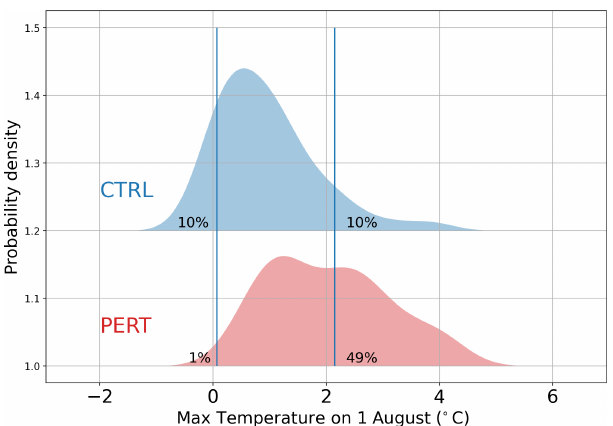
Figure 1. Probability density function of the maximum surface air temperature over Svalbard in CTRL (blue) and in PERT (red) on 1 August. The left and right vertical blue lines show the 10th and 90th percentiles of the CTRL on a 5d window, respectively. The percentage next to the vertical lines indicates the frequency of days exceeding the 10th (left) and the 90th (right) percentiles of the CTRL.